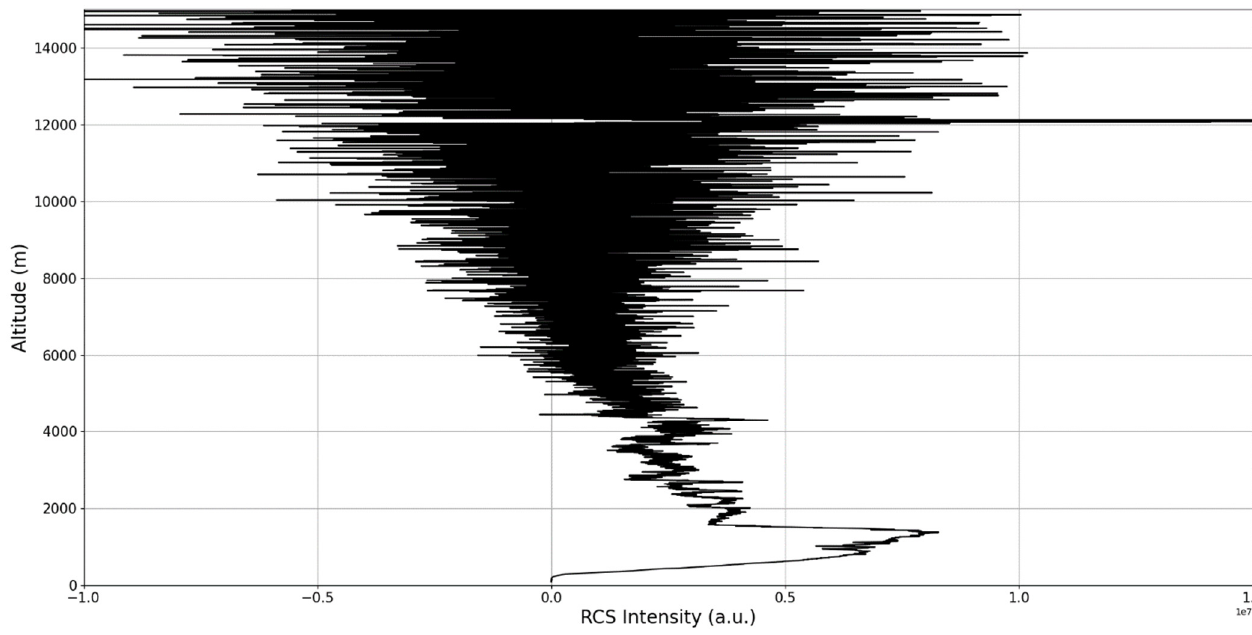
Figure 8. RCS profile corresponding to point C.